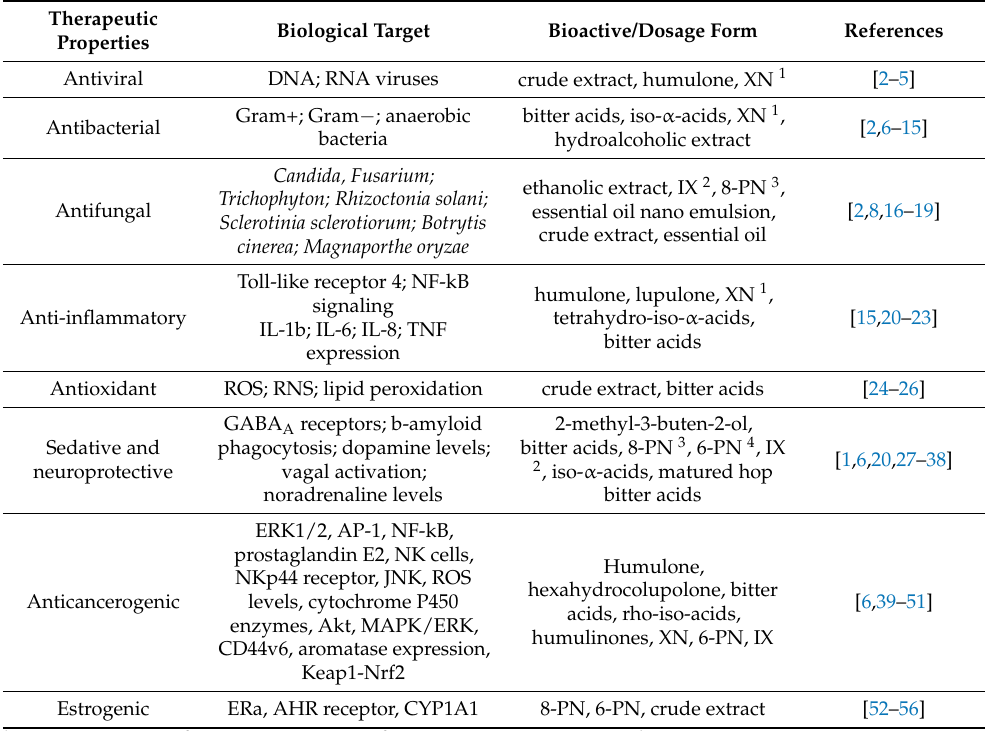
Figure 1. ( a ) Hop plant; ( b ) hop cones; ( c ) hop male inflorescences; ( d ) cross section of a hop cone containing lupulin. Table 1. Therapeutic potential of hops and related pure